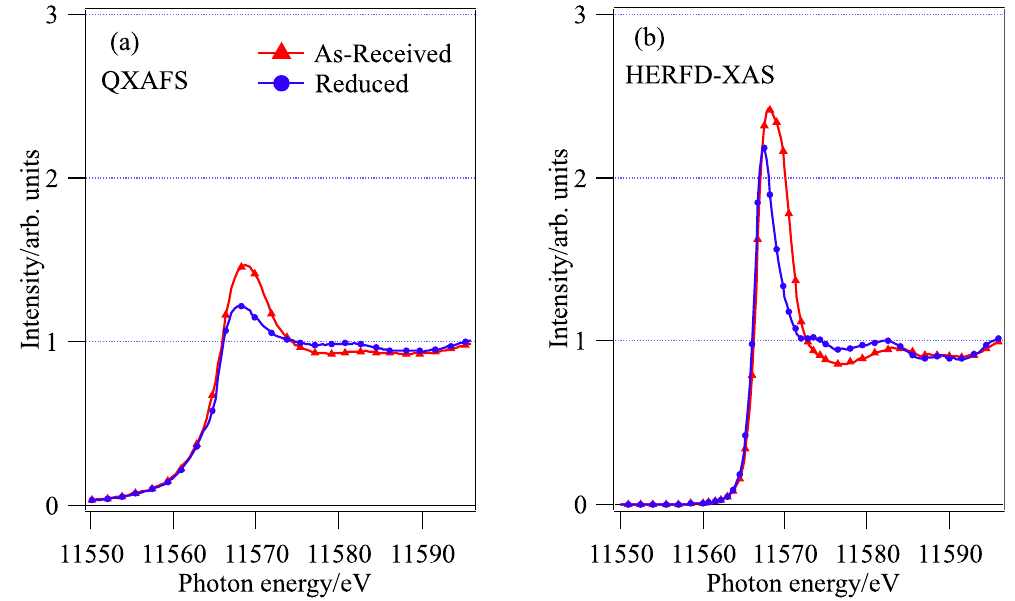
Figure 3. Pt L 3 edge XAS of Pt(A) with ( a ) QXAFS and ( b ) HERFD-XAS methods under as-received and reduced conditions. More features are distinguished in the high resolution HERFD-XAS spectra than QXAFS.